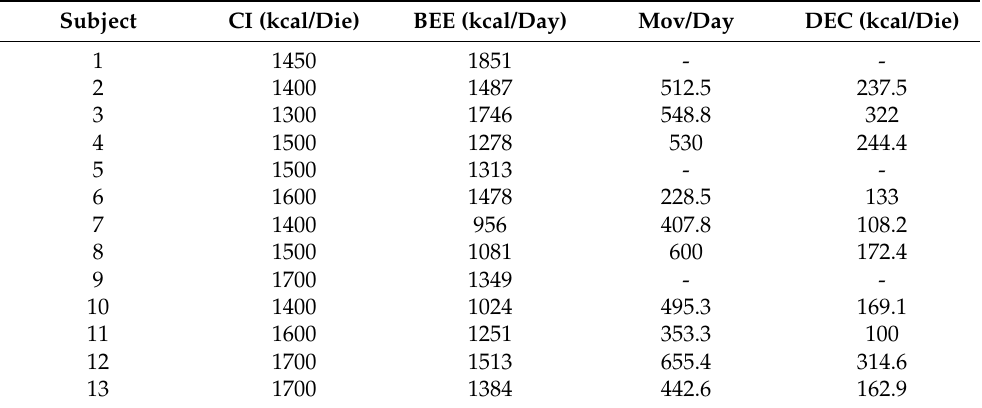
Table 2. Caloric intake of the diets administered, resting energy expenditure, and data from the accelerometer-based activity monitor.